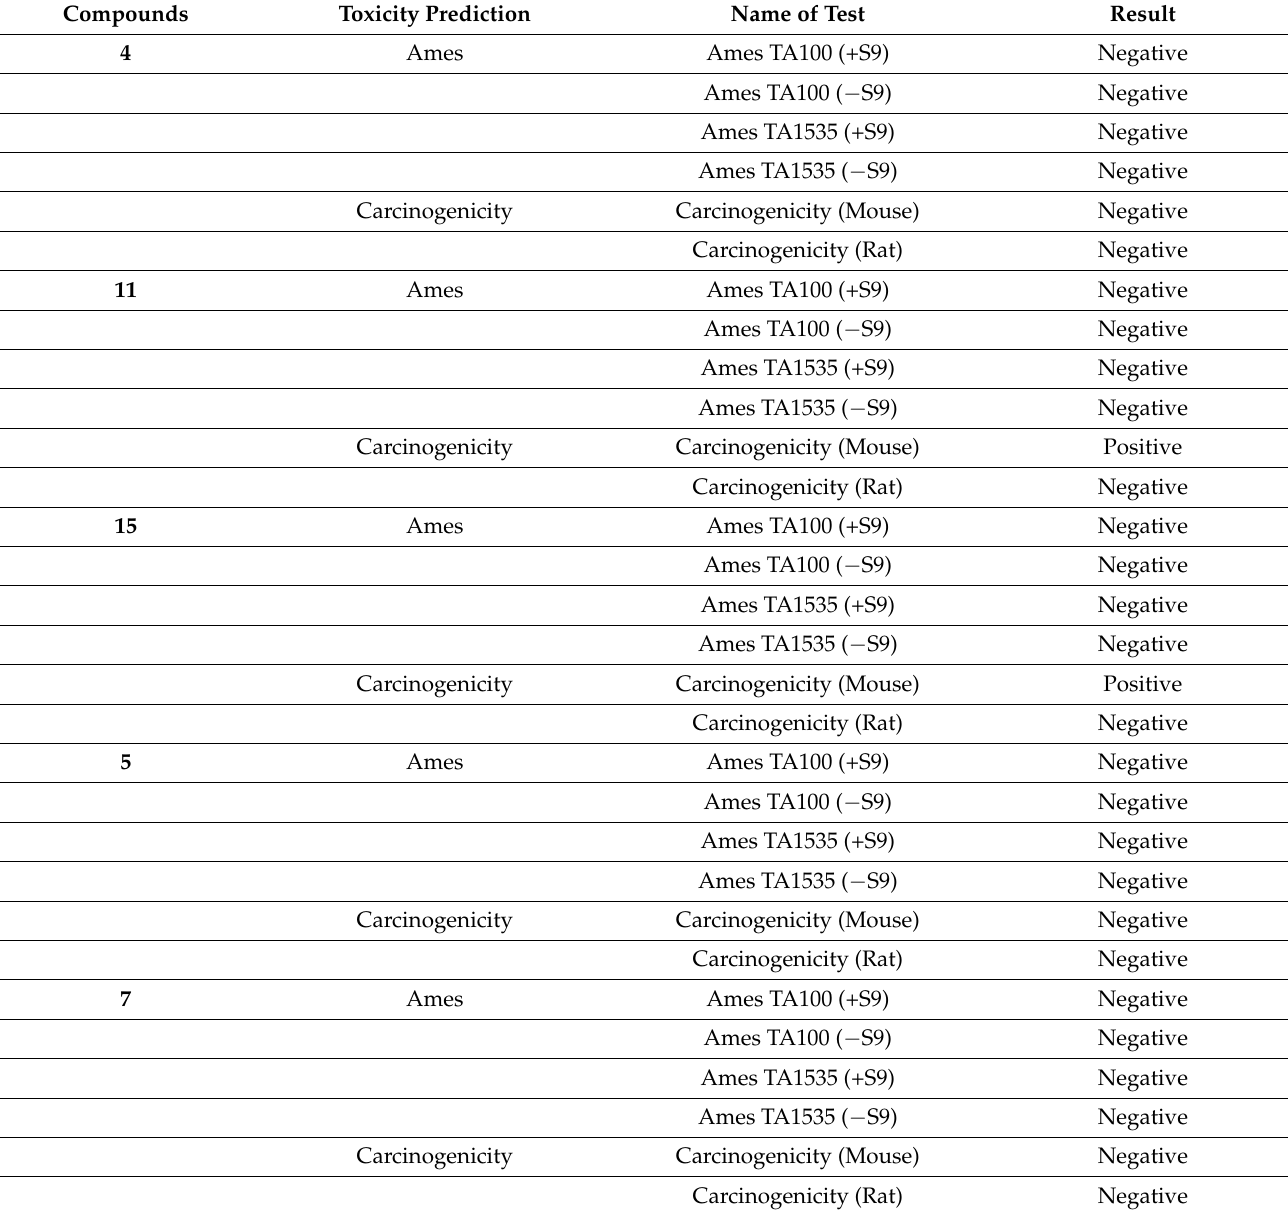
Table 2. Predicted pre-ADMET results of flavonoids acetamide derivatives from Ames test.